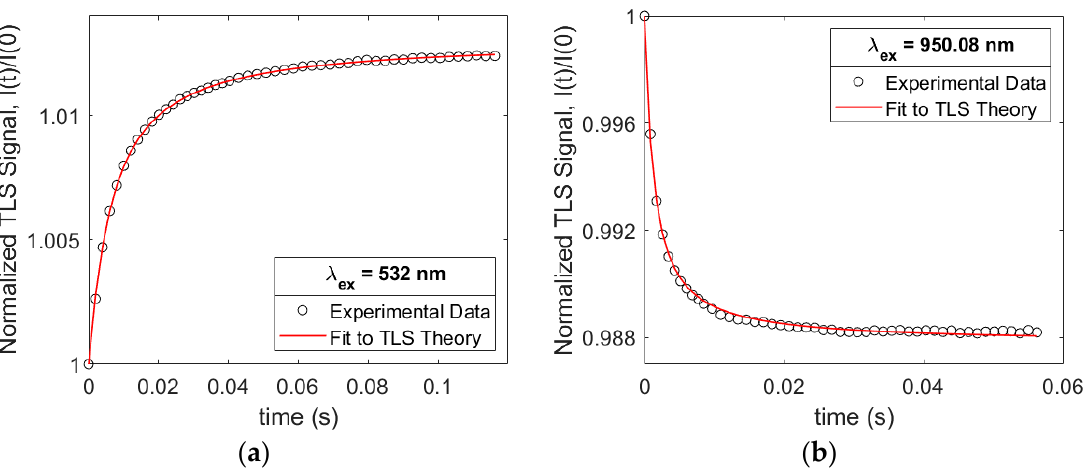
Figure 14. TLS transient signals for excitation wavelengths in the ( a ) absorptive (heating) and ( b ) emissive (cooling) spectral ranges in 0.02% Ti 3+ :Al 2 O 3 . Black circles are the measured TLS signal, and red curves are best fits that account for only thermal effects.